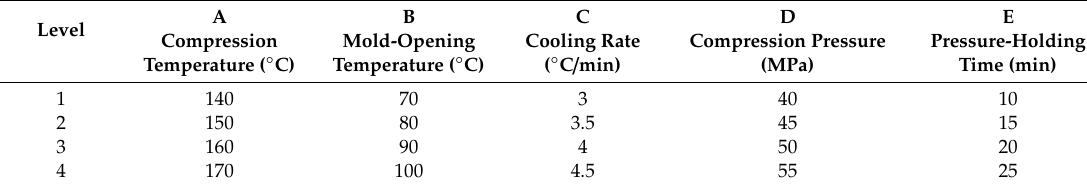
Table 2. The levels of the five parameters in the orthogonal tests.